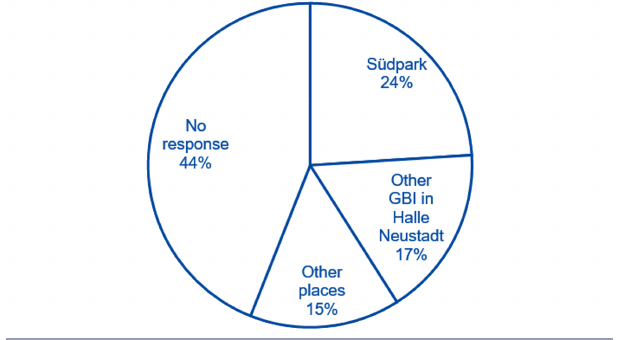
Fig. 9 . Urban green spaces visitation and non-visitation according to the 100 mental maps. GBI = green-blue